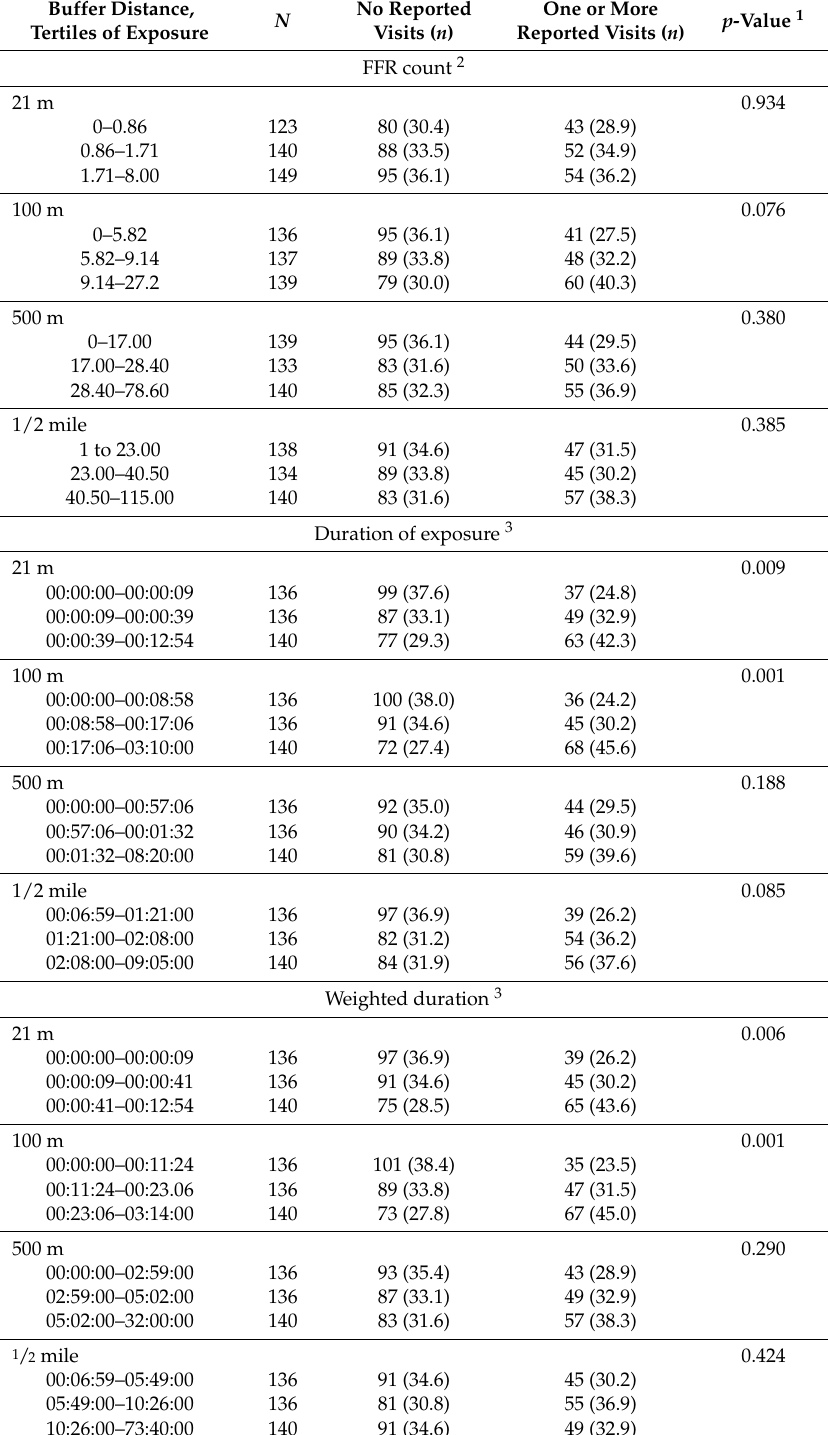
Table 3. Descriptive characteristics of FFR visitors and non-visitors by FFR exposure